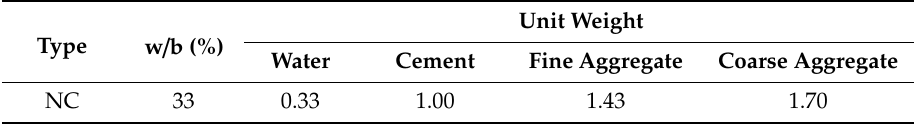
Table 2. Mix proportions of concrete (by cement weight ratio).